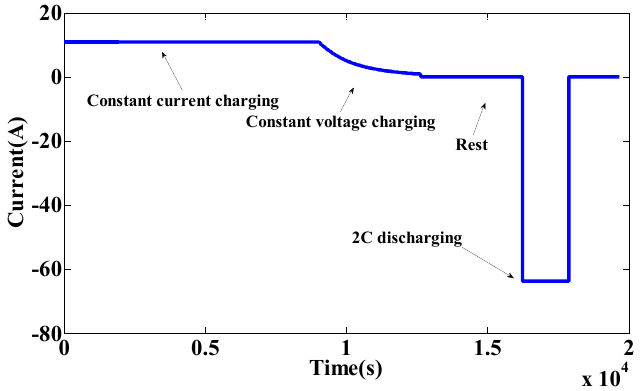
Figure 6. The battery testing currents.